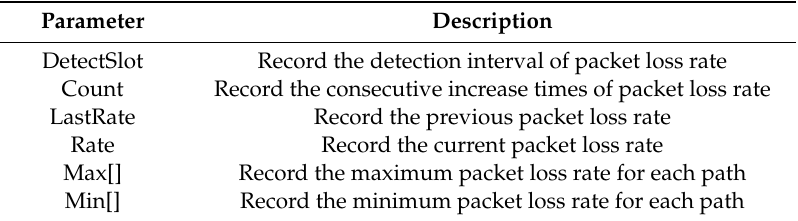
Table 4. Parameter settings of the TCP-SCTP method.